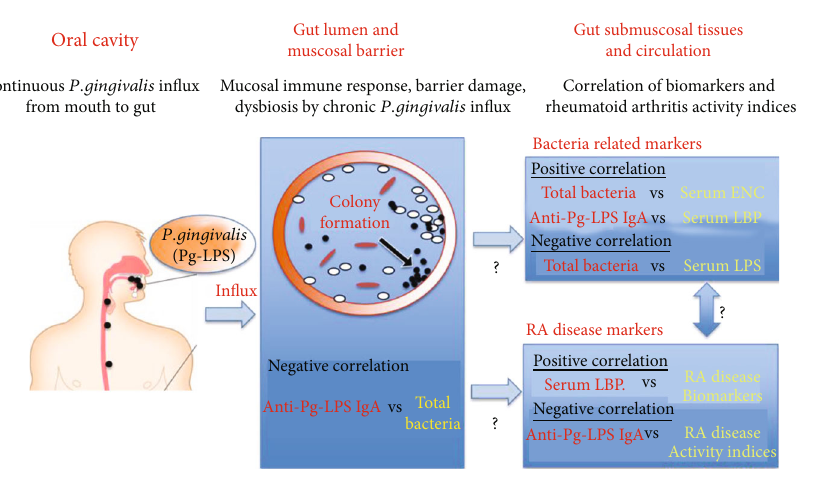
Figure 3: Oral-gut microbiome axis in rheumatoid